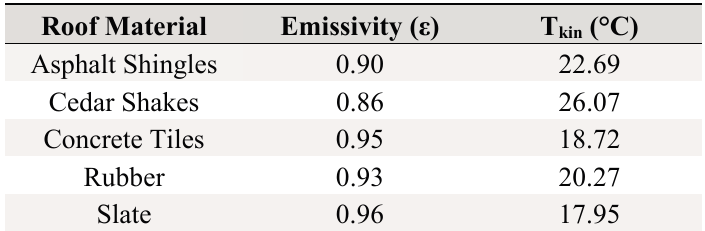
based on the emissivity value of different roof materials (defined kin of 15 rad